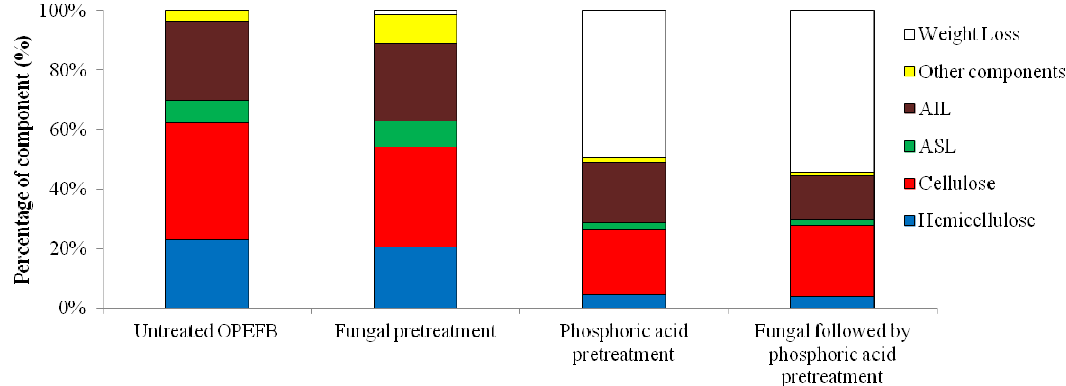
Figure 1. Profile of components of oil palm empty fruit bunches (OPEFB) after pretreatment. ASL: acid soluble lignin, AIL: acid insoluble